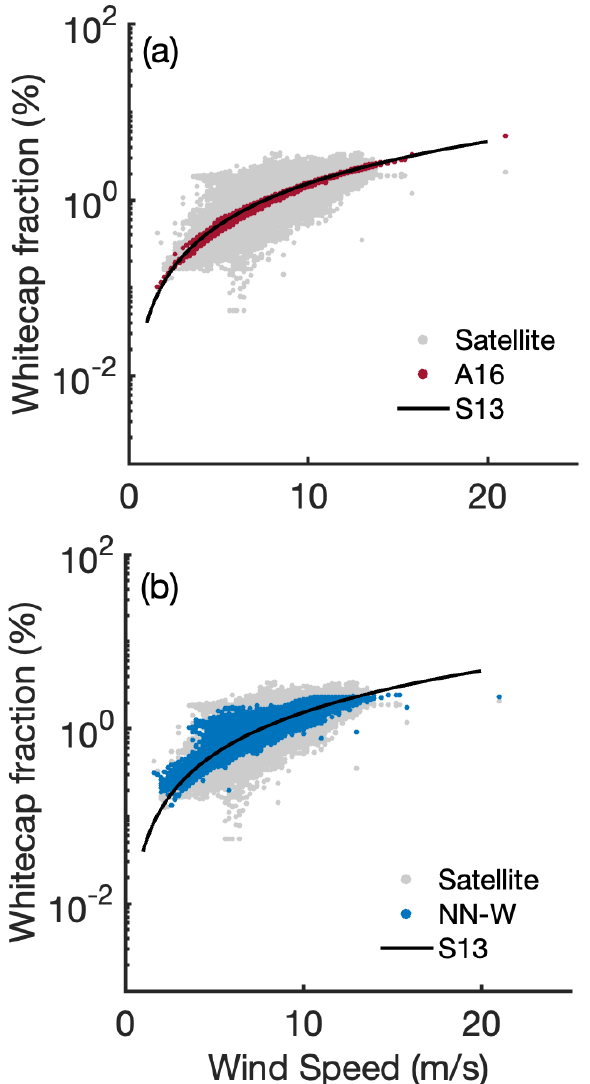
Figure 6. Satellite-derived W data for October 2006 at 37 GHz (gray symbols) compared to W values calculated from ( a ) A16 (red symbols) and ( b ) NN-W (blue symbols).